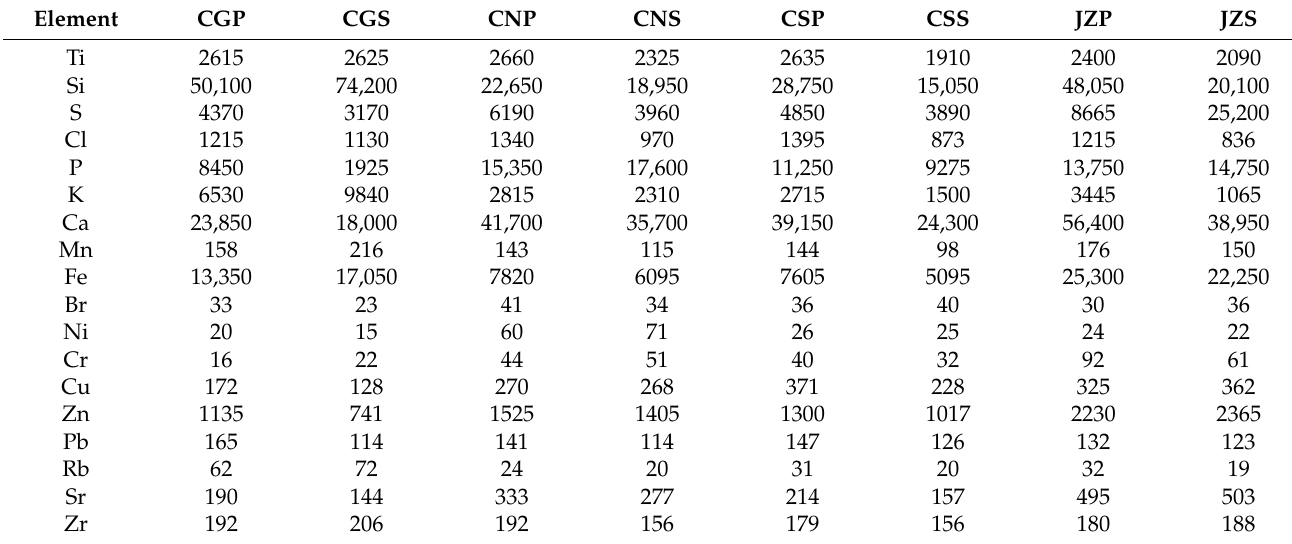
Table 1. The total concentration of trace elements [mg/kg] in the sewage sludge samples. The values are the average of two measurements. Combined standard uncertainty is around 10% for each measurement [58].